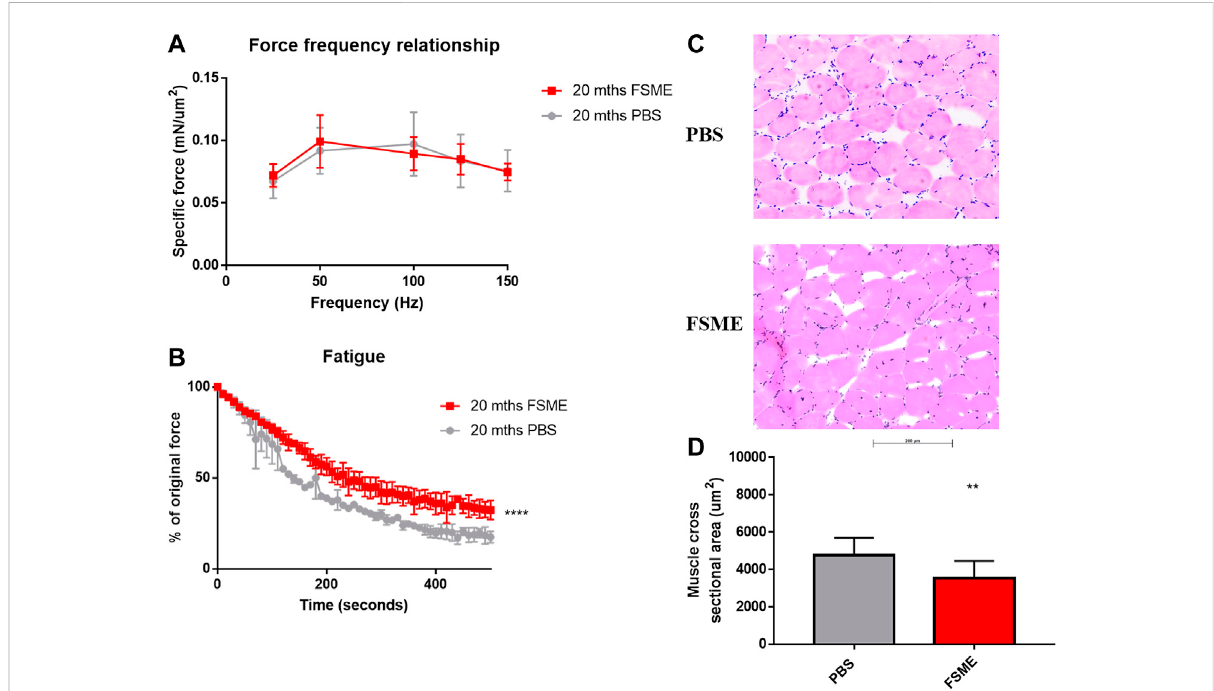
FIGURE 6 (A) Decrease in isometric twitch force of FSME treated mice under different stimulating frequency normalized with muscle cross section area. (B) Increased fatigue resistance of FSME treated mice gastrocnemius muscle. Results are presented as mean ± SD. Figure. (C) Representative IF staining and H&E staining of PBS and FSME group respectively. Figure. (D) Muscle cross-sectional area was larger in the PBS group. Data are presented as mean ± SD, **represents p < 0.01 by the non-parametric Mann – Whitney test method. N = 4; results are presented as mean ±